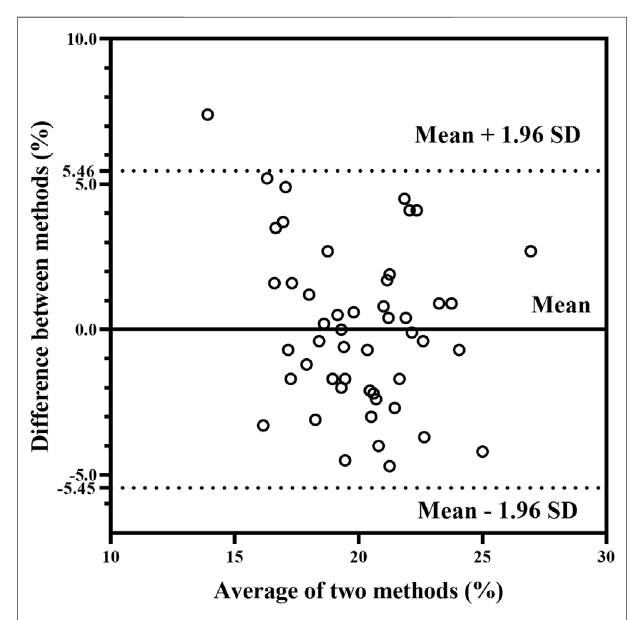
FIGURE 1 | Bland and Altman plots between TL HRV and TRIMP.